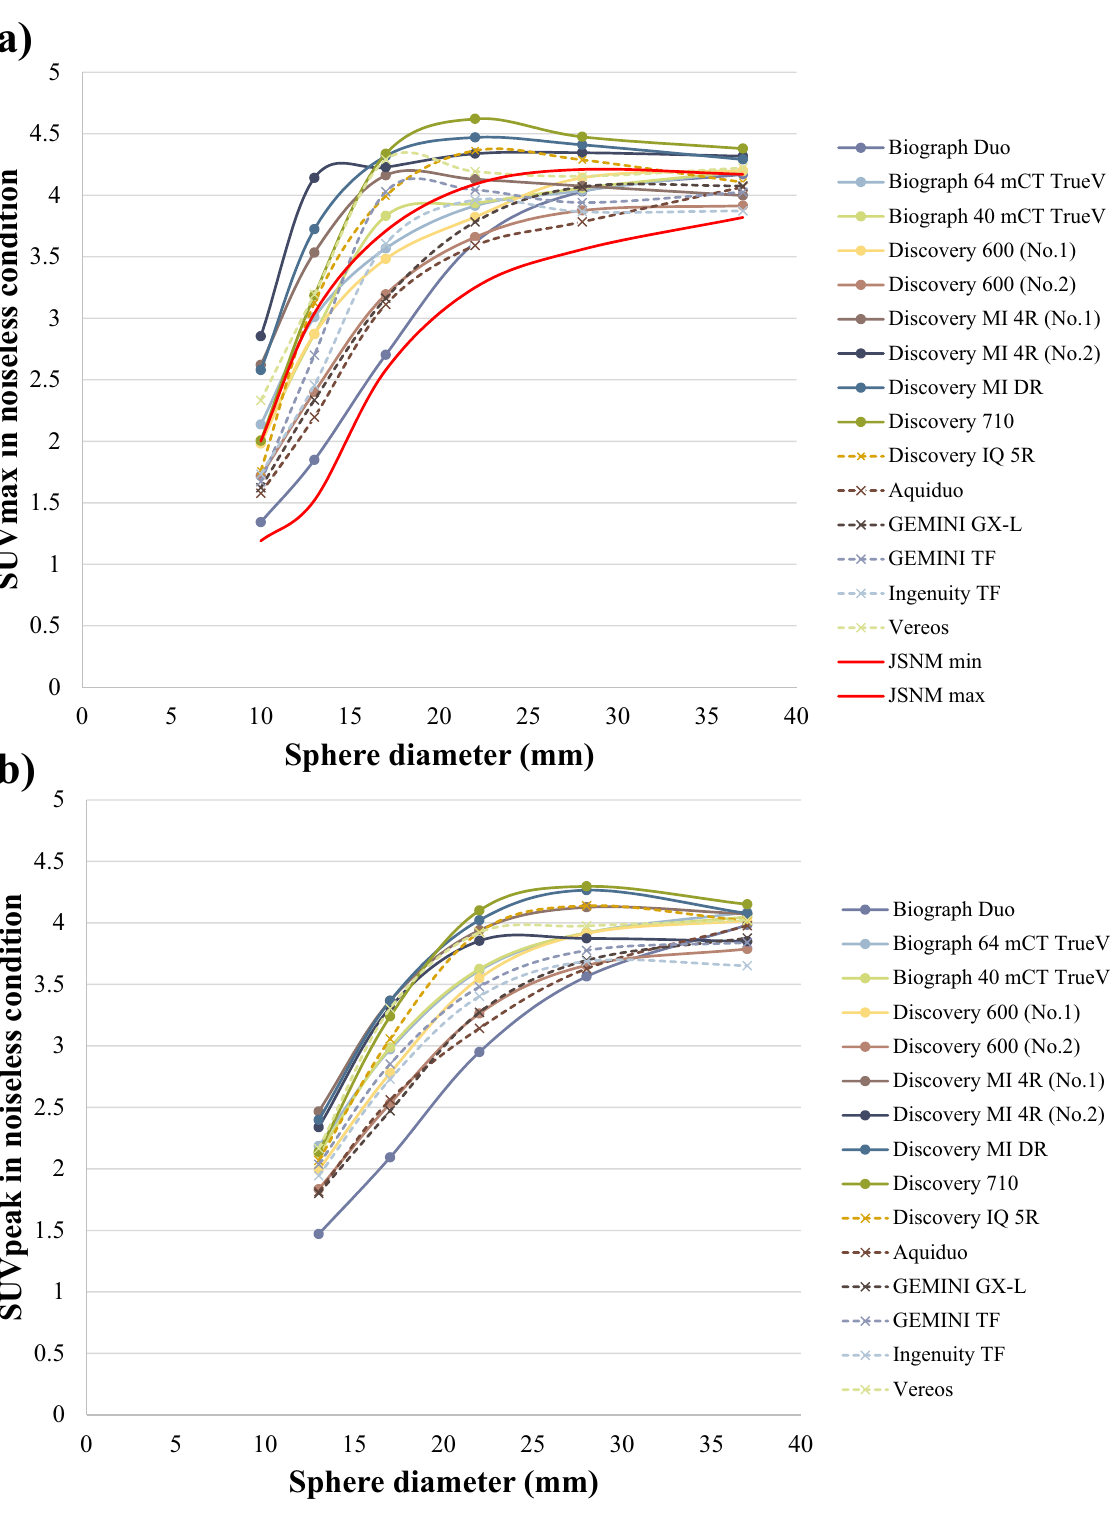
Figure 5. ( a ) SUVmax and ( b ) SUVpeak under each institution’s reconstruction parameters and noiseless conditions. The solid red lines show the upper and lower limits of the SUVmax defined according to the JSNM guidelines. Some scanners had an SUVmax that was higher than the upper limit. The harmonization range of the SUVpeak is not defined in the JSNM guidelines. The actual values obtained using each scanner are shown in Online Resource 1 (SUVmax) and Online Resource 2